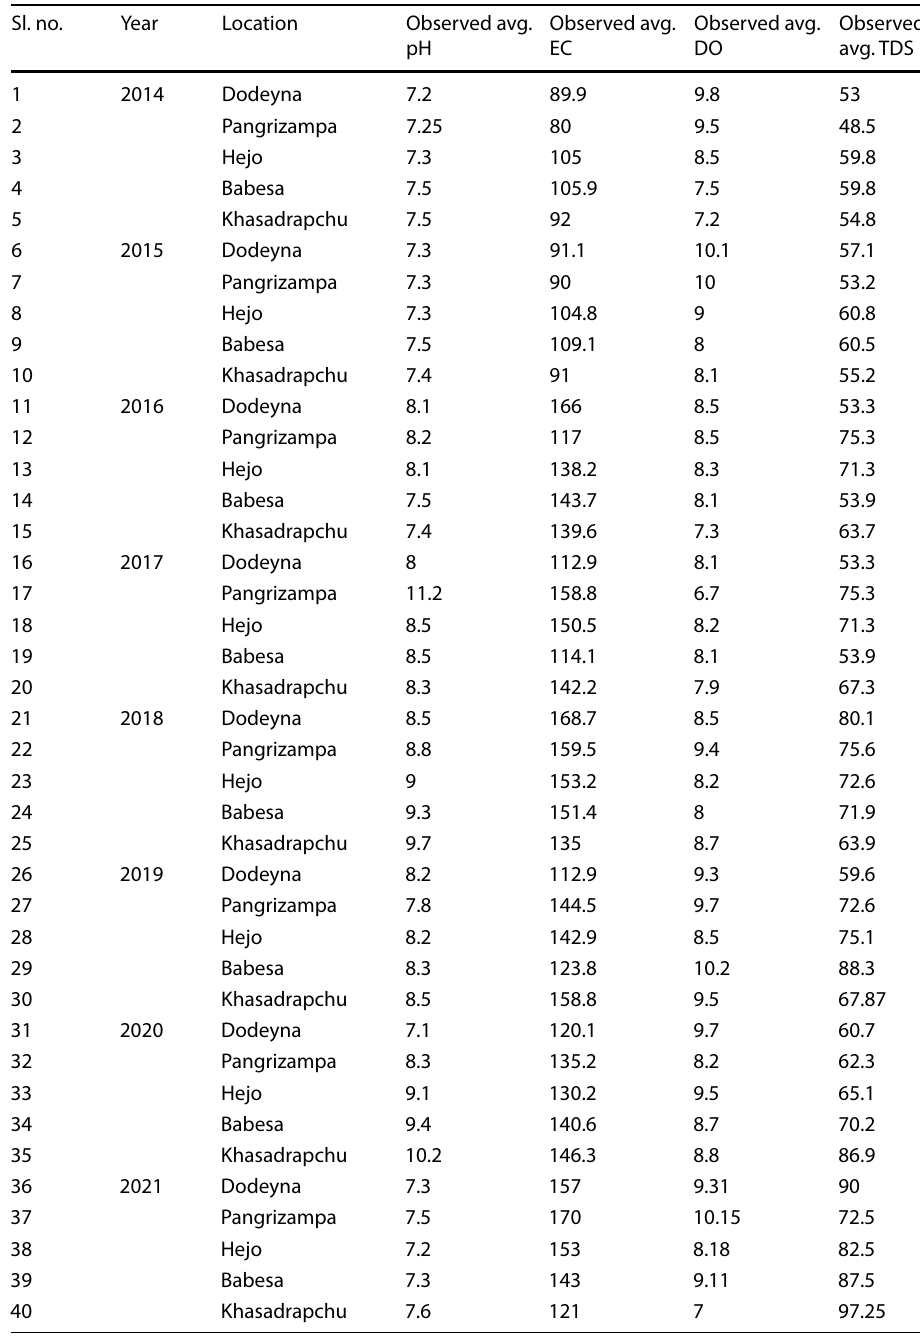
Table 1 Water quality